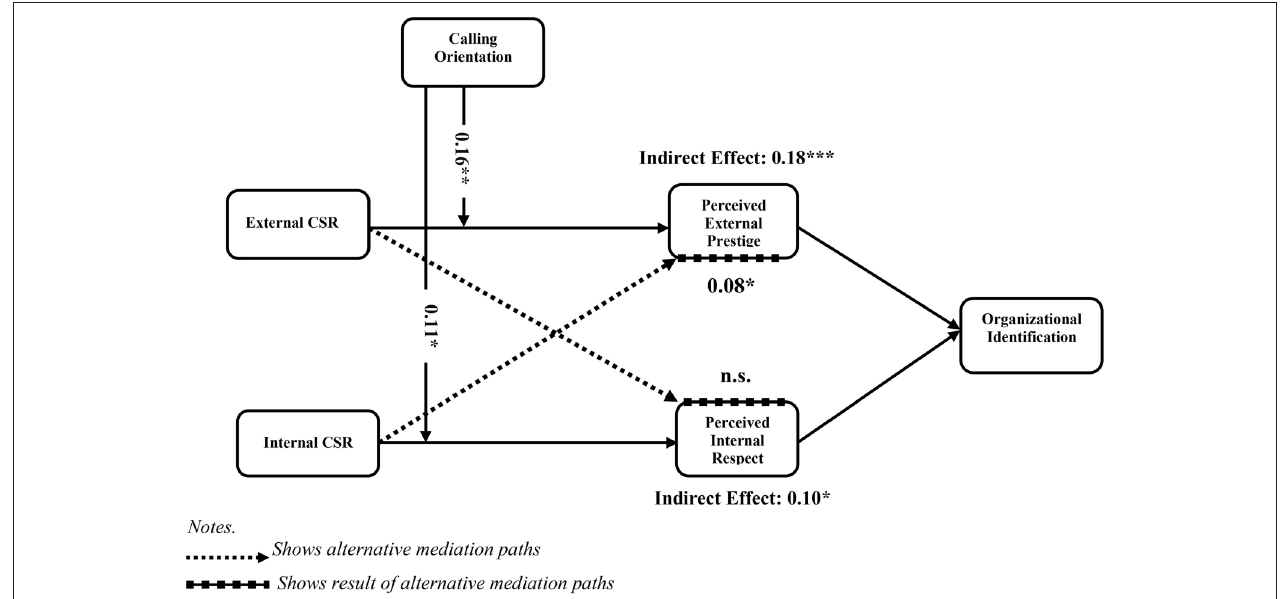
FIGURE 1 | Hypothesized